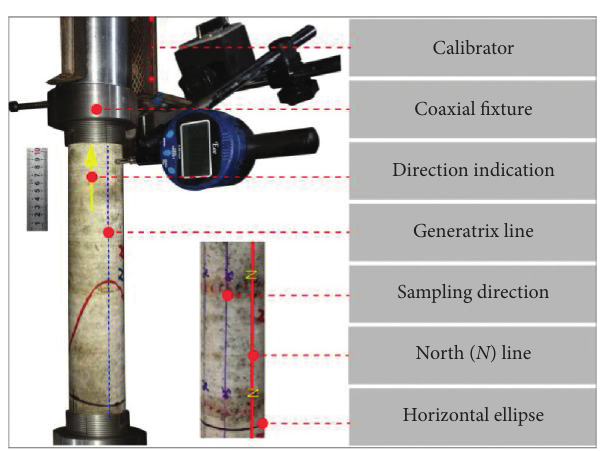
Figure 2: Reorientation of the nonorientation